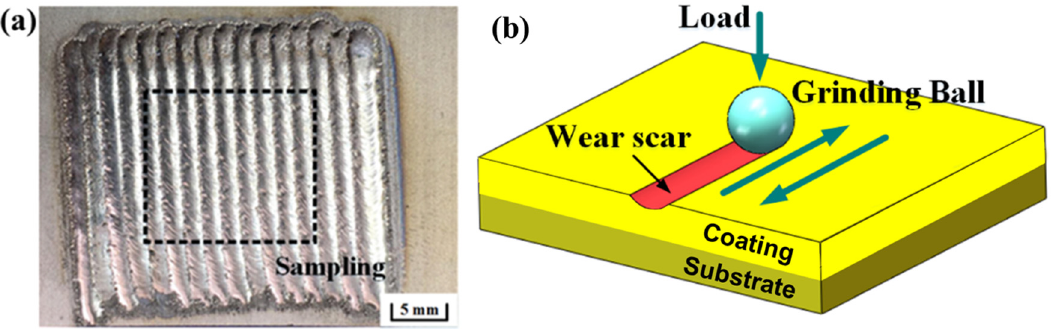
Figure 3. ( a ) Surface morphology of the coating; ( b ) schematic diagram of wear test. A VHX-1000 ultra-depth microscope (Keyence, Itasca, IL, USA) was used to measure the wear depth, width, and 3D morphology of the wear tracks. Each measurement was taken at three points in the wear scar area to obtain an average value. The SEM was used to observe the worn surface.